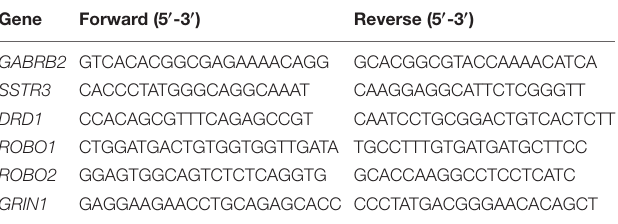
TABLE 1 | List of primers for qPCR of monkey samples. Gene Forward (5 (cid:48) -3 (cid:48) )